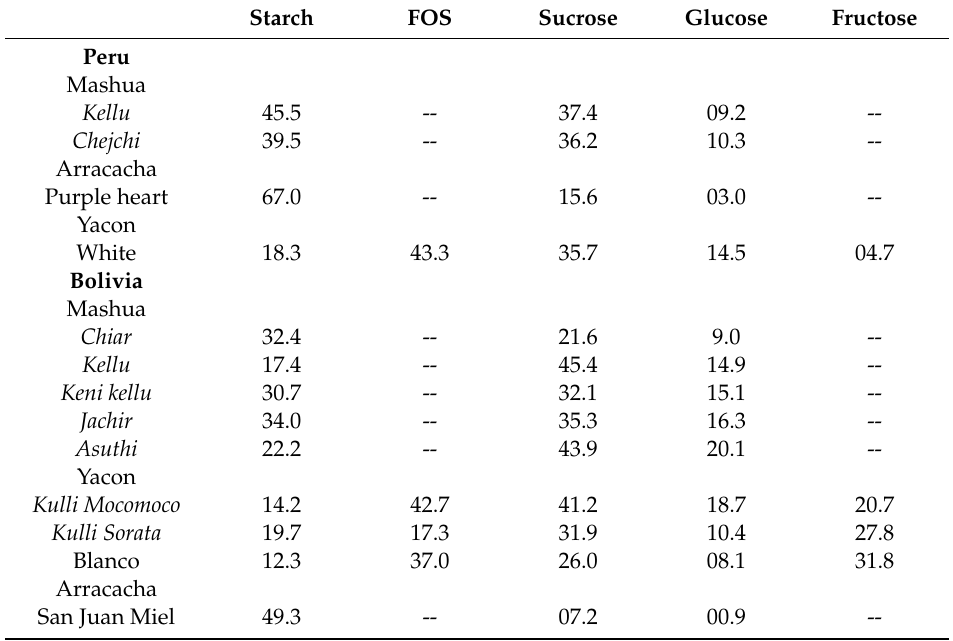
Table 3. Starch, fructooligosaccharides (FOS), and sugars in samples of mashua, arracacha, and yacon from Bolivia and Peru (g 100 g dry matter − 1 ). Starch FOS Sucrose Glucose